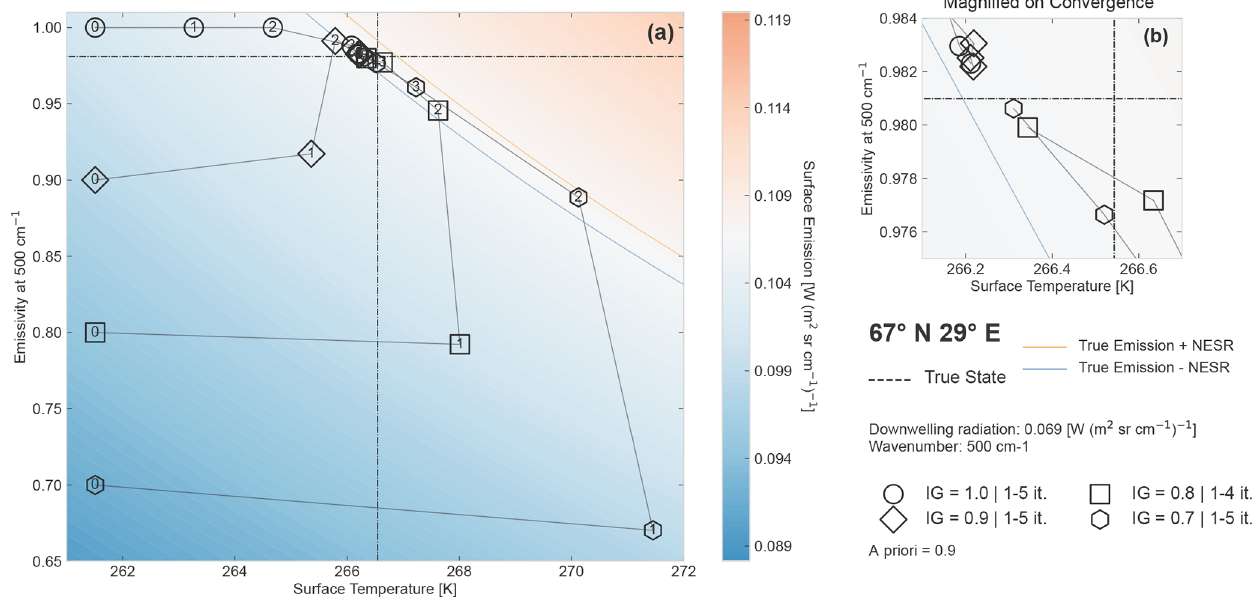
Figure A1. The value of the two elements of the retrieval vector for all retrieval iterations in the emissivity, with the surface temperature ( T s ) parameter space for the 67 ◦ N, 29 ◦ E coarse snow scene. Panel (a) shows the parameter space defined by T s and the emissivity at 500cm − 1 , with coloured contours corresponding to the surface emission at 500cm − 1 (according to Eq. 3), with the downwelling radiation set to the true value of 0.069W(m 2 srcm − 1 ) − 1 . The centre of the diverging colour scale is the true value of the surface emission. The true values of emissivity and surface temperatures are shown in dashed black lines. An orange (blue) line shows the contours of the true emission plus (minus) the FORUM noise equivalent spectral radiance (NESR) in the FIR. The different geometric marker shapes show the retrieval vector values for the iterations of four different retrievals, starting from the initial guess until the converged solution. In the four cases shown, the emissivity a priori is 0.9, and the initial guess takes the value of 1, 0.9, 0.8 and 0.7, as shown with circles, diamonds, squares and hexagons, respectively. All other retrieval parameters are the same for the four cases and are the default values outlined in Sect. 3. Panel (b) shows an enlarged portion of panel (a) centred on the true state for a clearer view of the later iterations (the colour scale and all other plotted values are the same as in panel a ). The full spectral range of the final retrieved emissivity values for the four runs is shown in Fig. 8 in Sect. 4 of the